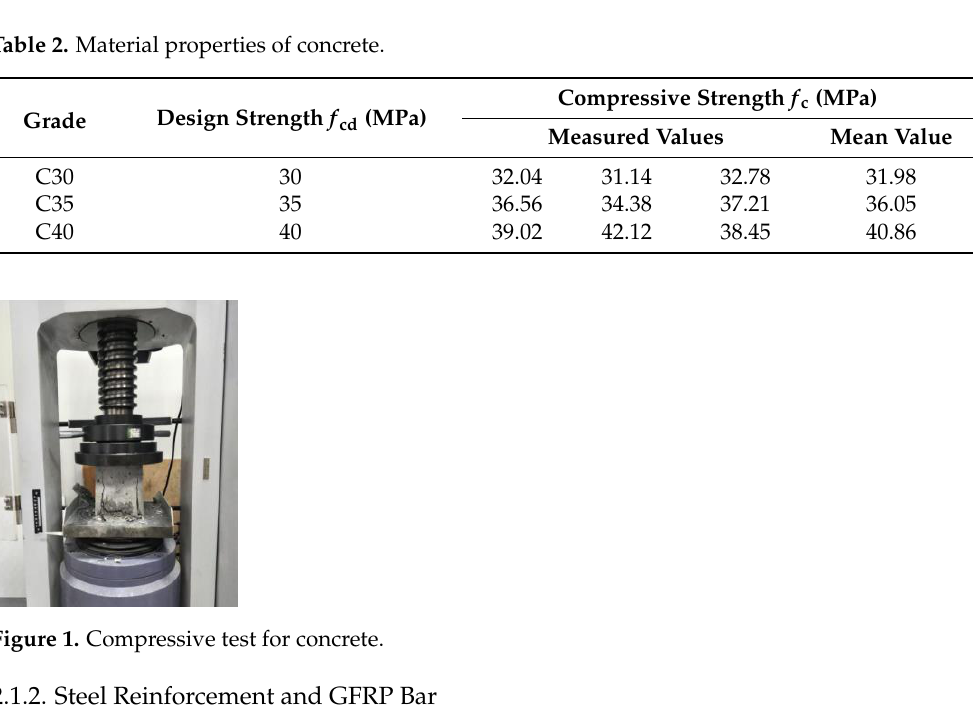
Table 2. Material properties of concrete.